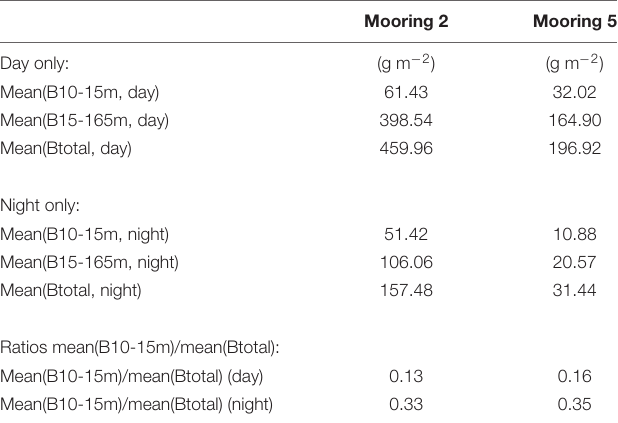
TABLE 5 | Comparison of biomass in the near-surface (10–15 m) to full (15–165 m) integration depth ranges.